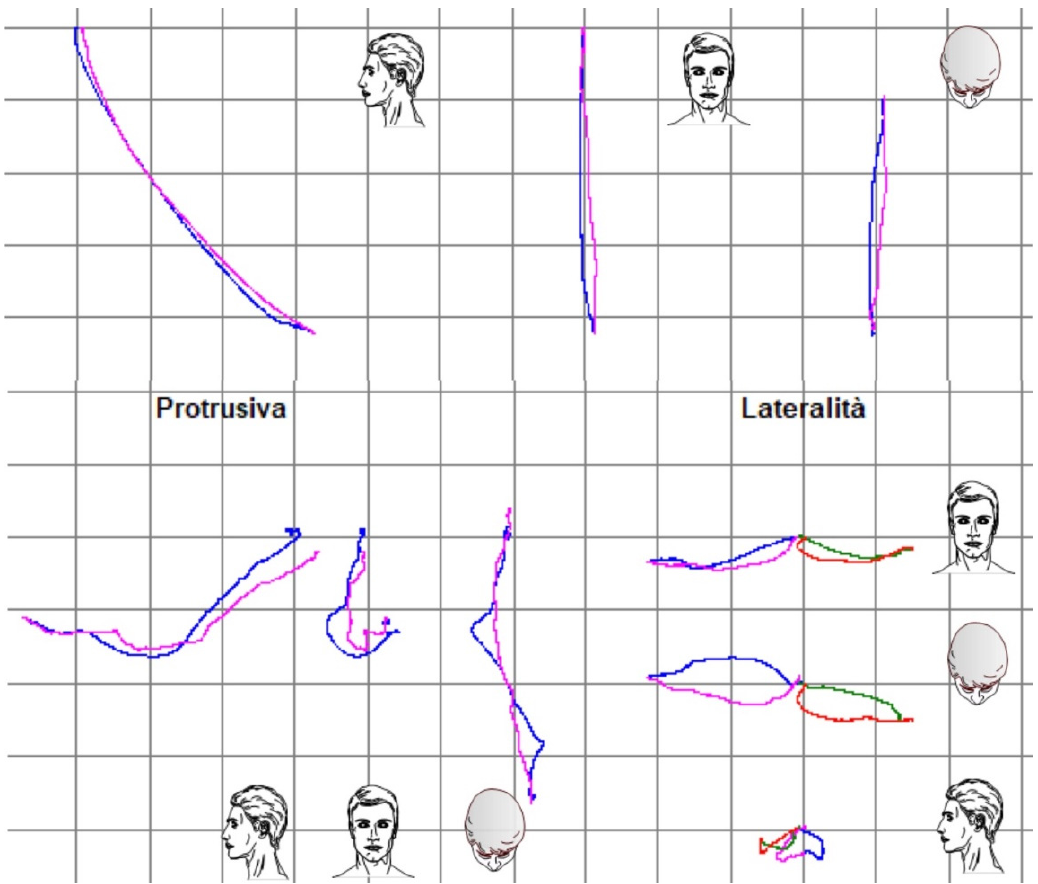
Figure 38. Comparison of kinesiograpic analysis before and after treatment.